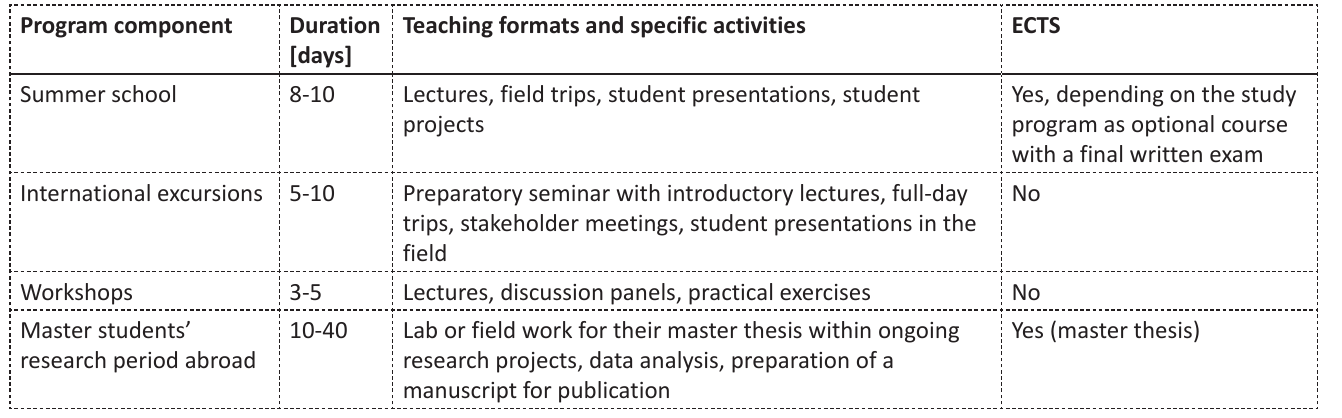
Landscape Online – supported by the International Association for Landscape Ecology and its community